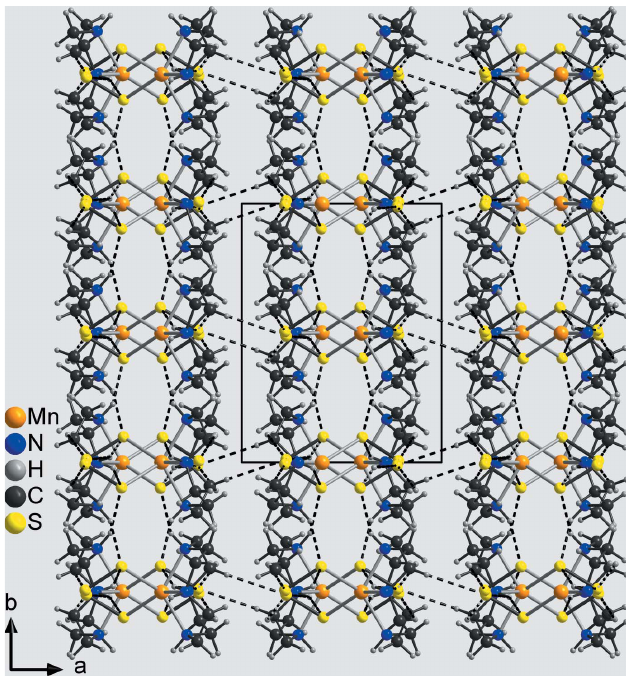
Figure 6 Crystal structure of the title compound viewed in the direction of the layers along the c axis with intermolecular N—H (cid:2)(cid:2)(cid:2) S and C—H (cid:2)(cid:2)(cid:2) S hydrogen bonds shown as dashed